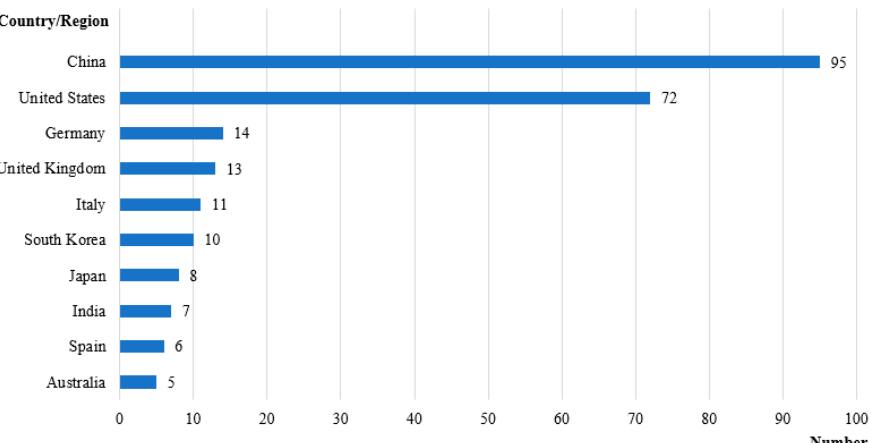
Figure 5. Publication country/region distribution.